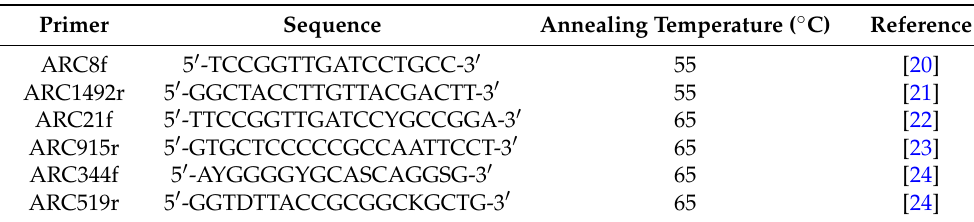
Table 1. Archaeal 16S rDNA